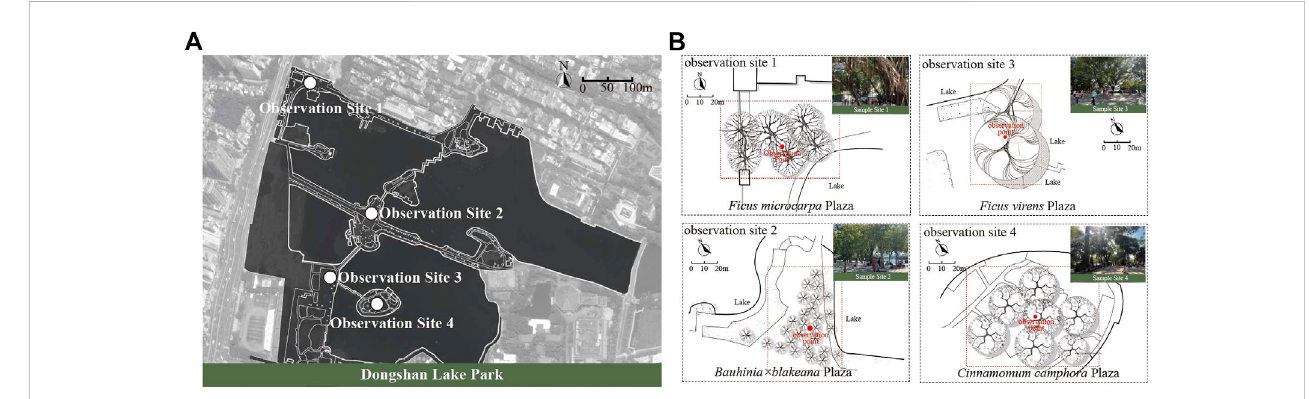
Study site (A) distribution map of the four measurement sites (B) sample site plan and fi eld